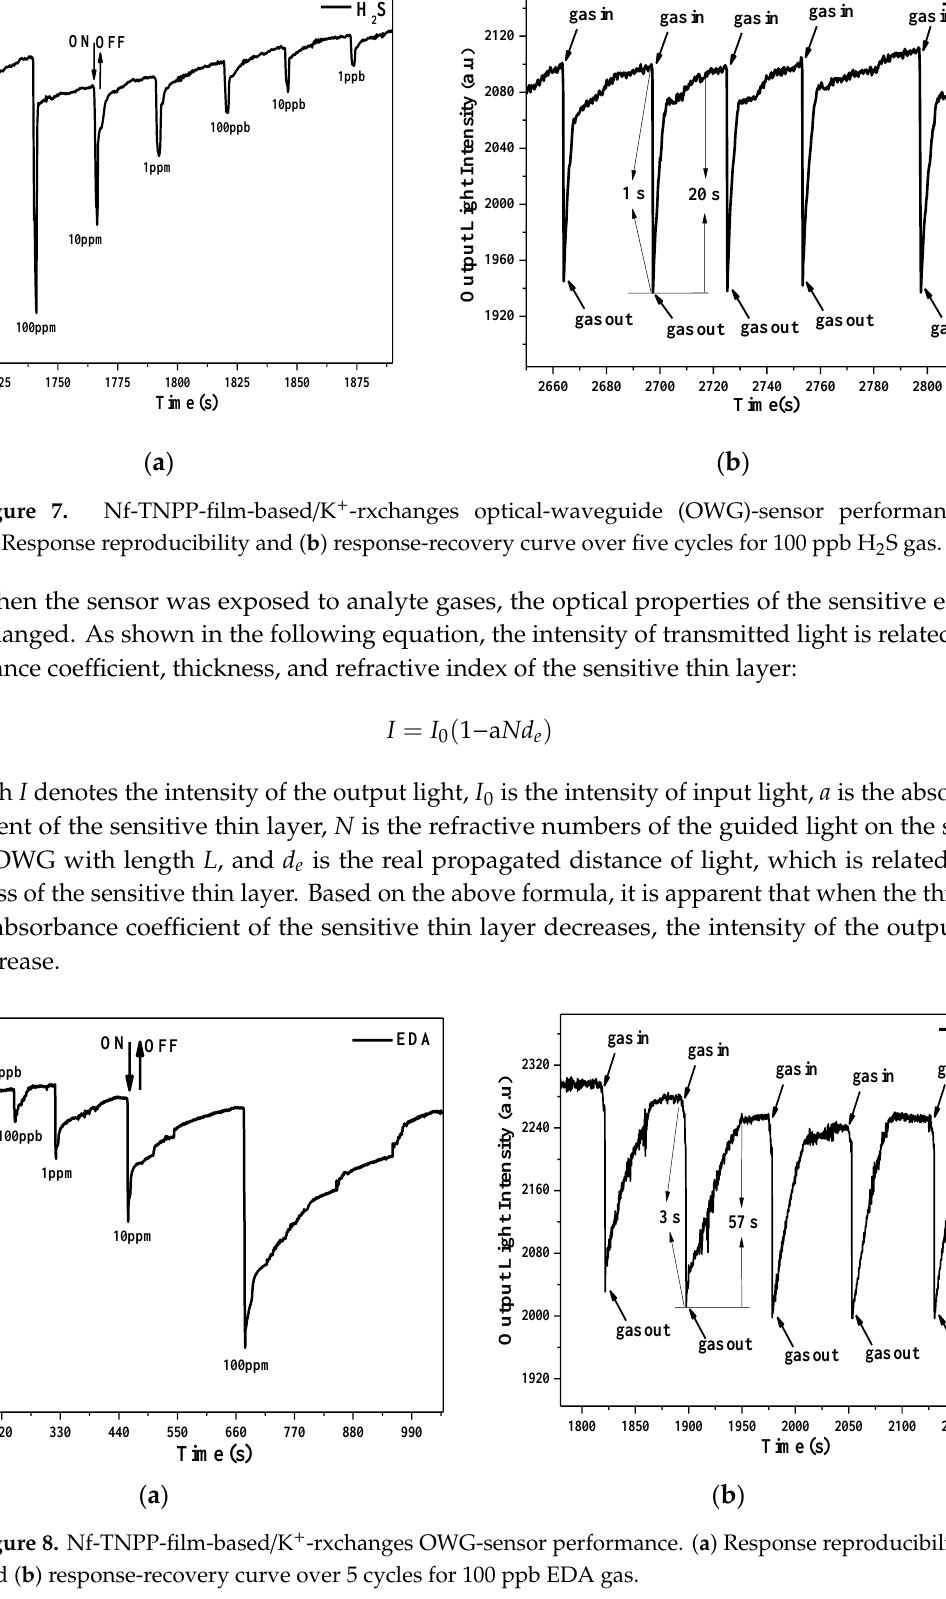
( b ) Figure 9. Relationship between the response intensity and the concentration of ( a ) H 2 S and ( b ) EDA vapour 5. Conclusions In summary, TNPP was synthesized and dissolved in a solution of Nafion, after which it was used to prepare Nf-TNPP thin films by spin coating. Absorption and 1 H NMR spectra of TNPP were acquired. The surface morphologies of the TNPP and Nf-TNPP thin films were investigated by AFM, which revealed that the surface of the Nf-TNPP film was smoother than that of TNPP. Planar OWG sensors of K + -exchanged TNPP and Nf-TNPP thin films on glass were prepared and were used to detect VOCs. Among them, the Nf-TNPP thin film exhibited preferable optical responses to H 2 S and